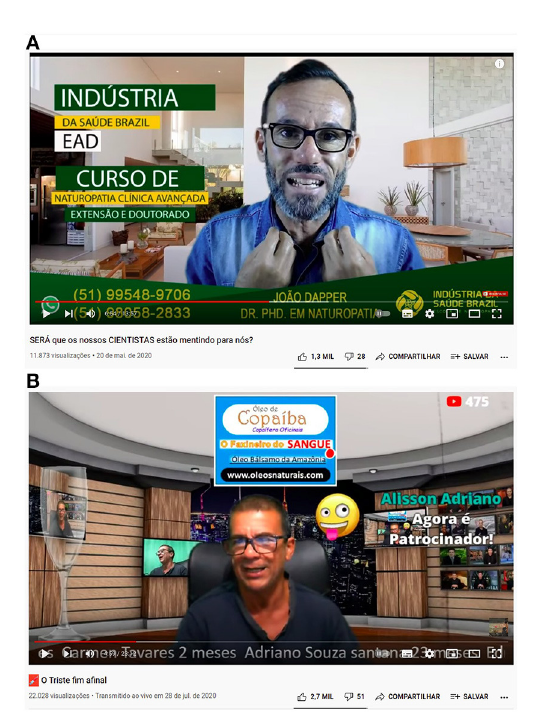
FIGURE9 (A,B) The channels Nutrição Alimentos & Cia and Verdade Oculta showing forms of monetization alternative to YPP.